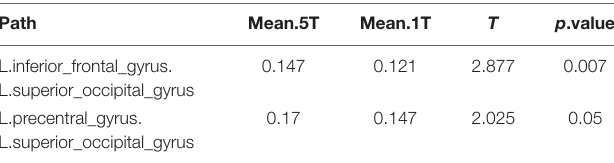
Frontiers in Human Neuroscience |